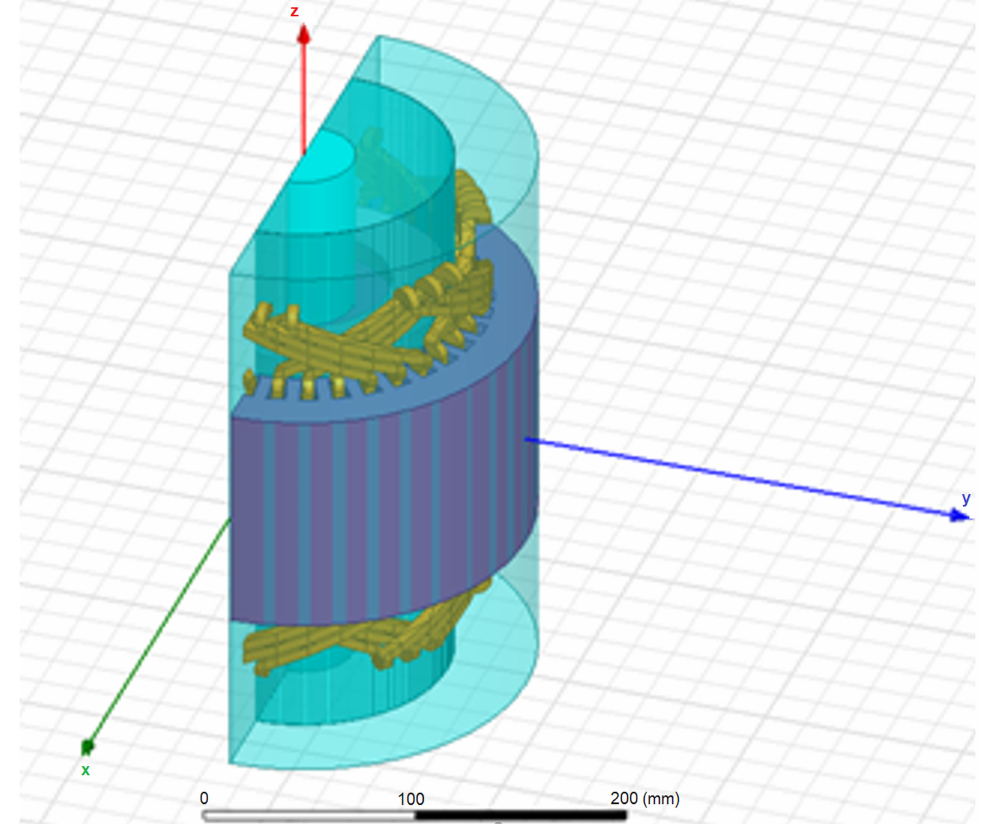
Figure 12. Automatically generated Maxwell 3D project.